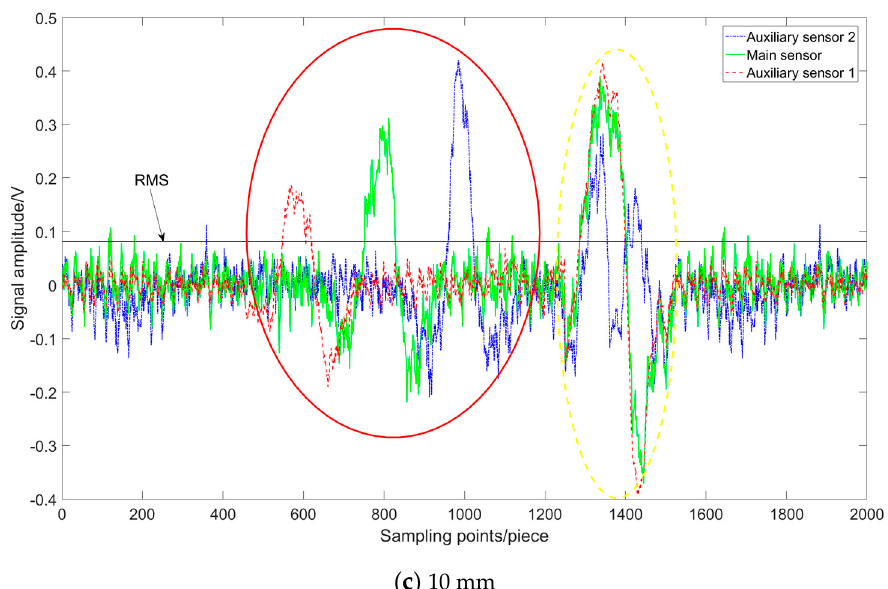
Figure 11. x -component results with different distance.